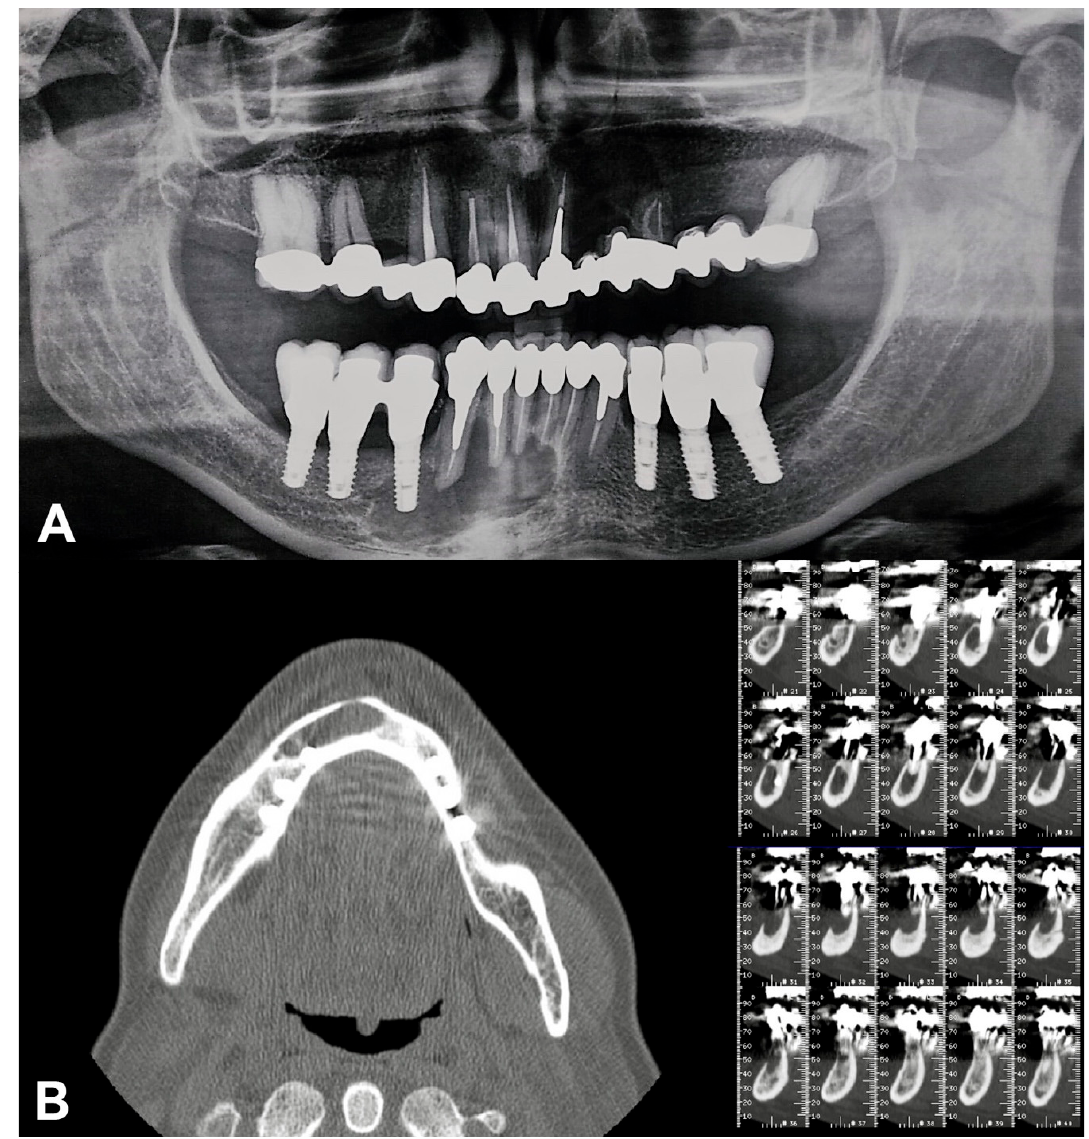
Figure 1. Pre-surgical radiographical examinations. ( A ) Orthopantomography; ( B ) Cone Beam Computed Tomography.